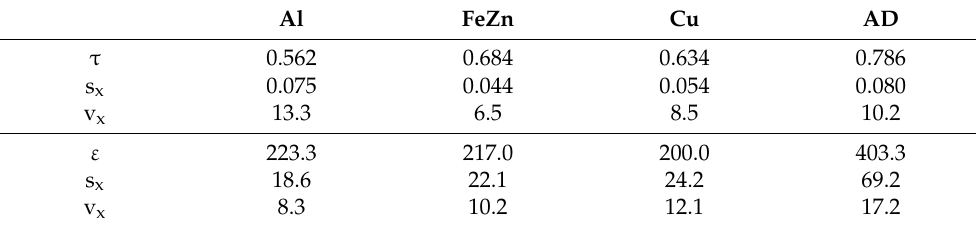
Table 2. Results of shear adhesion τ (in MPa) and elongation ε (in %), standard deviation s x (in MPa for τ , in % for ε ) and coefficient of variation v x (in %) 1 for aluminium alloy (Al), galvanised